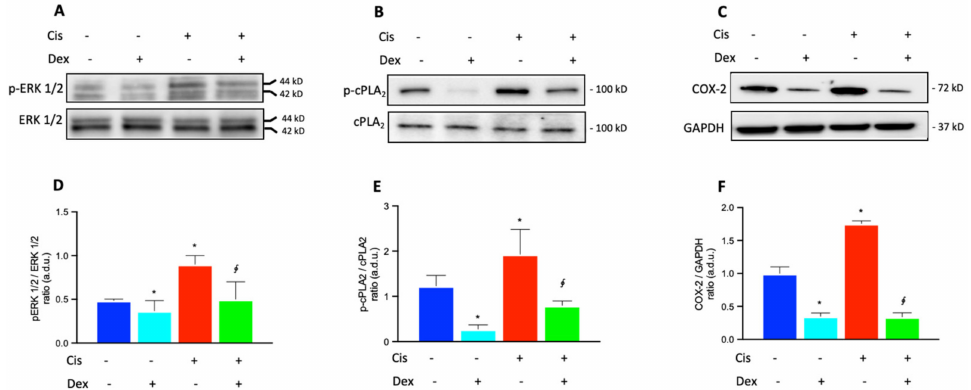
Figure 3. Immunoblot analysis was performed using specific antibodies against p-ERK 1/2 and total ERK 1/2 ( A ), activated (phosphorylated, p-cPLA 2 ) and total cPLA 2 ( B ), and COX-2 ( C ) proteins. The blots were probed with anti-GAPDH (reference) antibody to verify the equal loading of 30 µ g protein per lane. Image J software Version 1.52a, NIH, Bethesda, MD, USA). was used to carry out a densitometric analysis of the immunoblots, indicating protein quantification of each band (in arbitrary densitometry units, a.d.u.). Quantitative analysis of western blots for the phosphorylation rate of ERK 1/2 (ratio of p-ERK 1/2/ERK 1/2 in ( D )) and cPLA 2 (ratio of p-cPLA 2 /cPLA 2 in ( E )) are indicated. Quantitative analysis of western blots for COX-2 protein was normalized to GAPDH ( F ). ( D – F ): each treatment is represented by a different color: control cells are blue, dexamethasone-treated cells are light blue, cisplatin-treated cells are red and cells treated with cisplatin plus dexamethasone are green. The data are representative of three independent experiments with four parallel samples for each group in each experiment and are expressed as mean ± SD. * p < 0.05 vs. cells without treatment; (cid:72) p < 0.05 vs. cells treated with cisplatin. The non-parametric Mann-Whitney test was used for pairwise